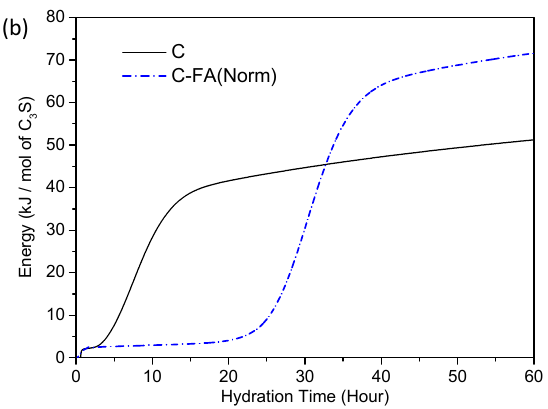
Figure 4. The results of isothermal conduction calorimetry. ( a ) Rate of heat evolution for pure C 3 S(C) and the C 3 S substituted with 50% by fly ash (C-FA). C-FA was normalized against the C 3 S content, as shown in C-FA(Norm); ( b ) Cumulative heat evolved for C and C-FA(Norm). The end of the induction period of C and C-FA occurred at approximately 1.5 and 15 h, respectively. Compared to pure C 3 S, however, the heat flow peak height increased for C-FA per mass of C 3 S after the induction period. As a result, C-FA showed a higher normalized cumulative heat evolution after 33 h relative to pure C 3 S. Based on the results, the degree of C 3 S hydration ( α ) was obtained by dividing the accumulated heat evolution by the enthalpy of the following C 3 S reaction: